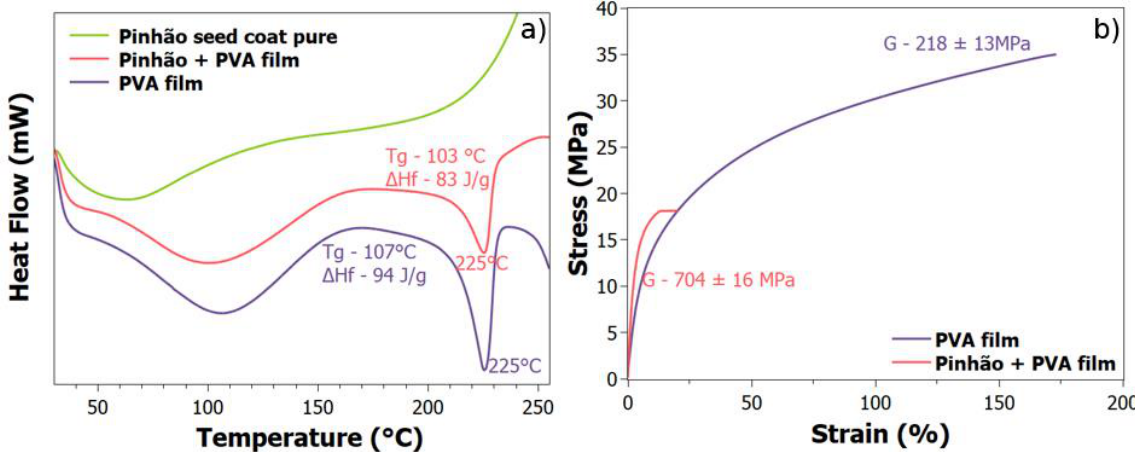
Figure 4. ( a ) Differential scanning calorimetry for pinhão seed coat pure, PVA film and Pin- hão/PVA film; ( b ) Stress-strain curves for the PVA film and Pinhão/PVA film.